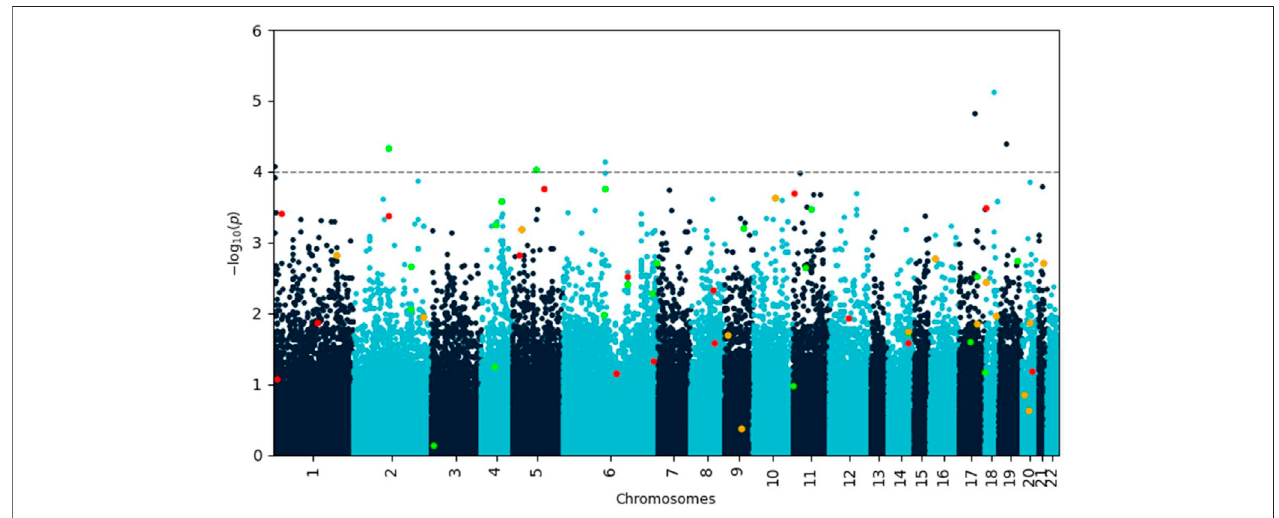
FIGURE1| Manhattanplotofnegativedecadiclogarithmof p -valuesforSNPsasdeterminedbySAIGEanalysis.Variantsidenti fi edbyLassowithfeatureselection are highlighted inred and green if theyincreaseordecrease disease risk,respectively. Variants highlightedin orange occurin both protectiveand risk-enhancing groups of SNPs, depending on their genotype. Most of these biologically meaningful variants would have been missed by using a simple p -value cutoff.